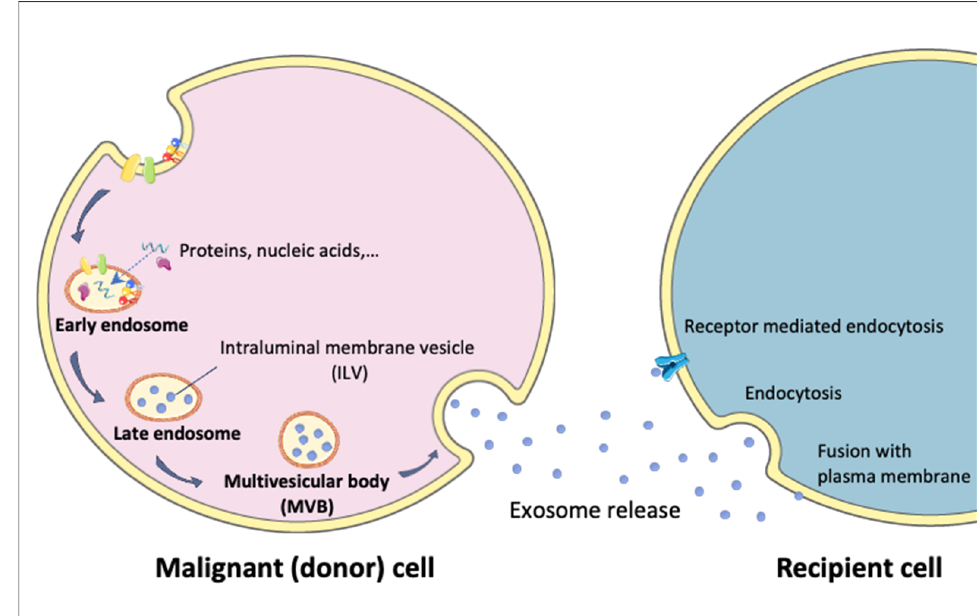
Figure 2. Schematic representation of exosome biogenesis and uptake. Exosome biogenesis proceeds in several steps: early endosomes are produced directly from the plasma membrane; ILV are included into the MVB formed after the maturation step involving a decrease in the pH; MVB fusion with plasma membrane led to exosome secretion; exosome capture by the recipient cell can be mediated via three mechanisms: (1) endocytosis by the plasma cell; (2) receptor-mediated endocytosis; (3) direct fusion with the plasma membrane.